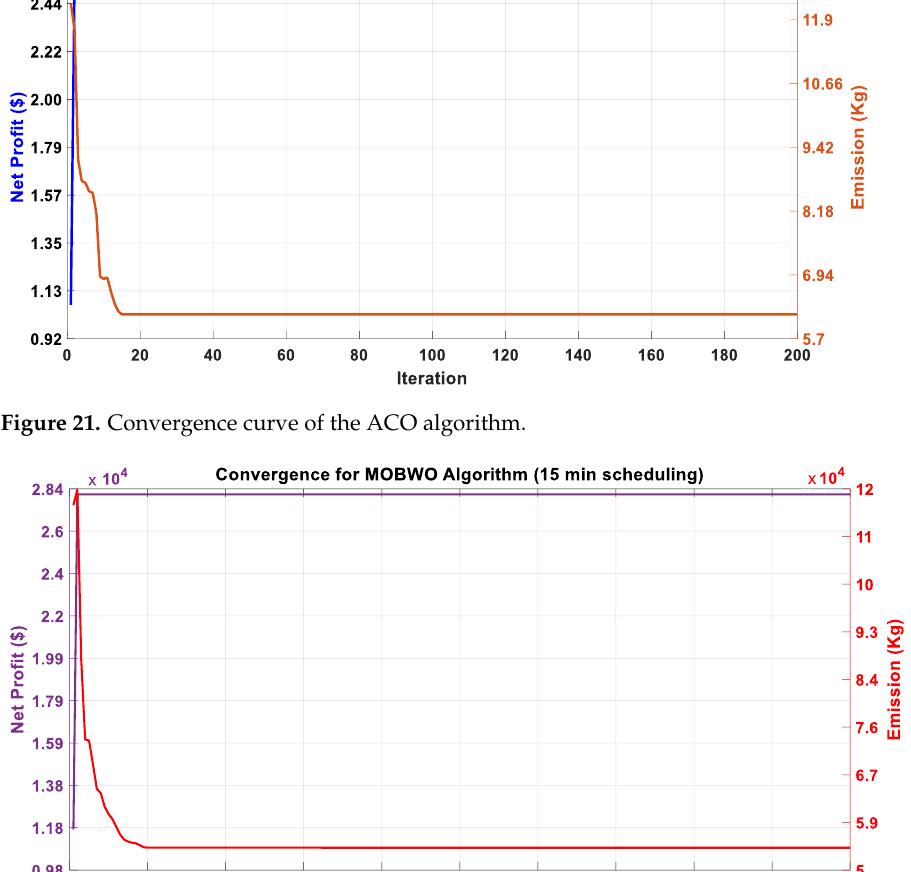
Figure 22. Convergence curve of the proposed MOBWO algorithm.